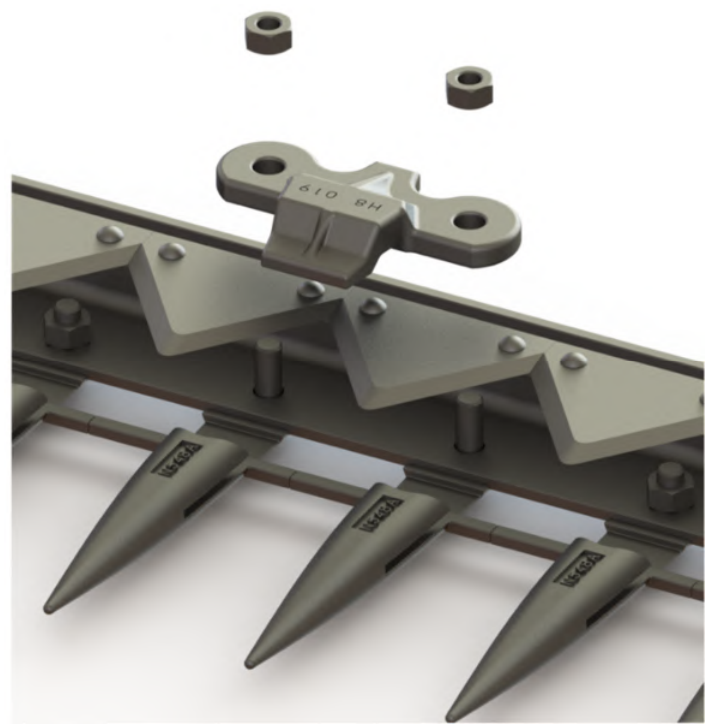
Figure 5. Limit positions of the blades.